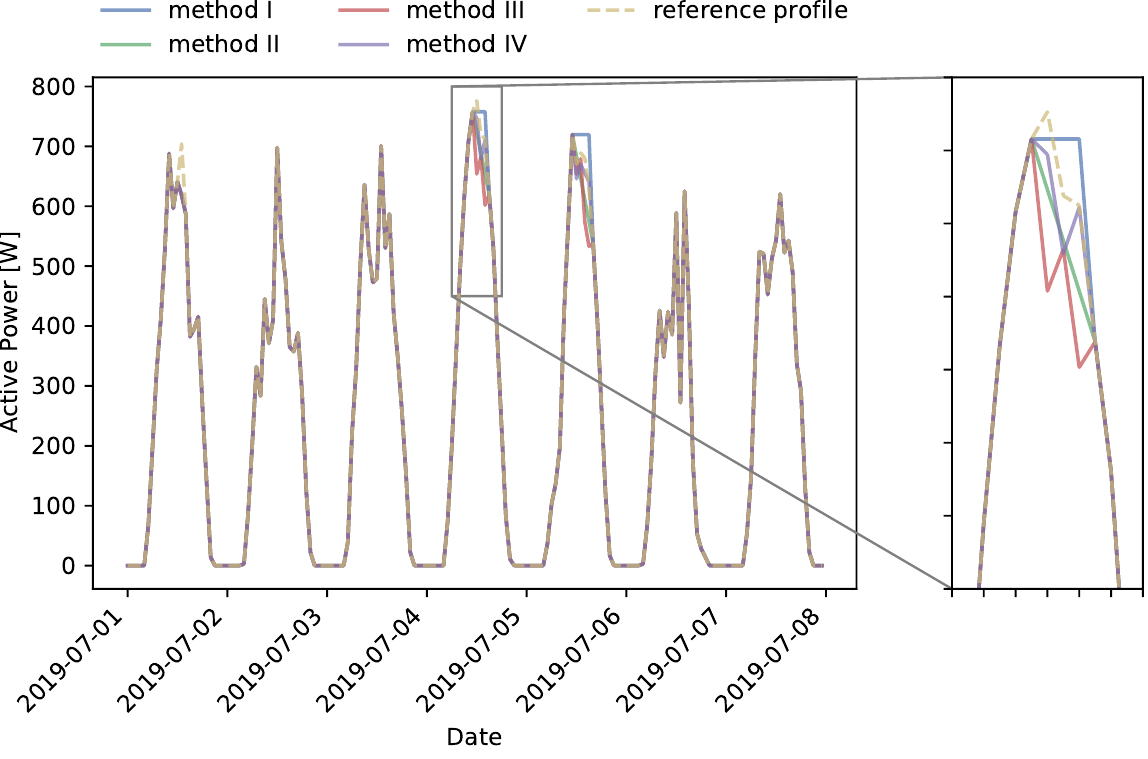
Figure 15. Comparing different baselining methods for curtailment option